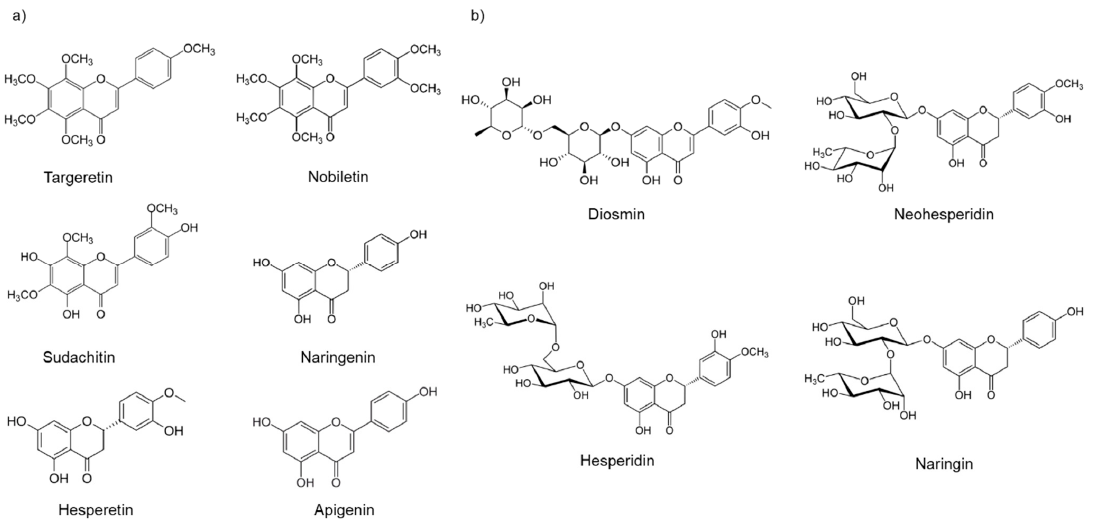
Figure 2. Chemical structures of the citroflavonoids were found in selected articles of the systematic searching; ( a ) aglycones, ( b ) glycosides. Sketched structures were designed by ChemDraw Professional 20 software (PerkinElmer, Inc., Waltham, MA, USA). Hesperidin, naringin, and naringenin (naringin aglycone) were the most studied cit- roflavonoids. Plasma biomarkers of carbohydrate and lipid metabolism, such as glucose and lipidic molecules (cholesterol, triglycerides, lipoproteins), liver function biomarkers (TGP, TGO, and alkaline phosphatase), were the most evaluated parameters for determin- ing the bioactivity of citroflavonoids in diabetes. Moreover, body weight changes over time were assessed in almost all studies despite the low activity on this parameter. In ad- dition, functional metabolic assays were also performed to establish changes in glucose uptake, insulin tolerance, and other metabolic pathways (Table 1). Table 1. Study design of selected articles on diabetes animal models. No Compound Name